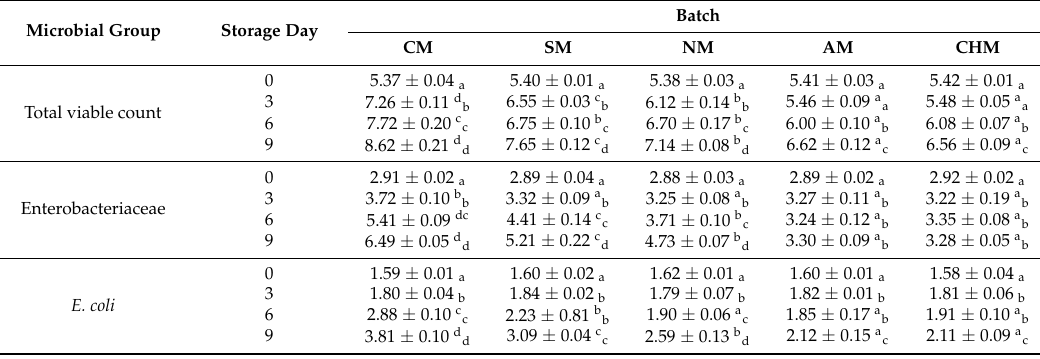
Table 3. Microbial changes in minced meat contaminated with Listeria monocytogenes Lhica 4 in the five different batches elaborated during storage time. Results are expressed as log cfu/g. Different superscript letters in the same row indicate significant differences ( p < 0.05). Different subscript letters in the same column and microbial group indicate significant differences ( p <